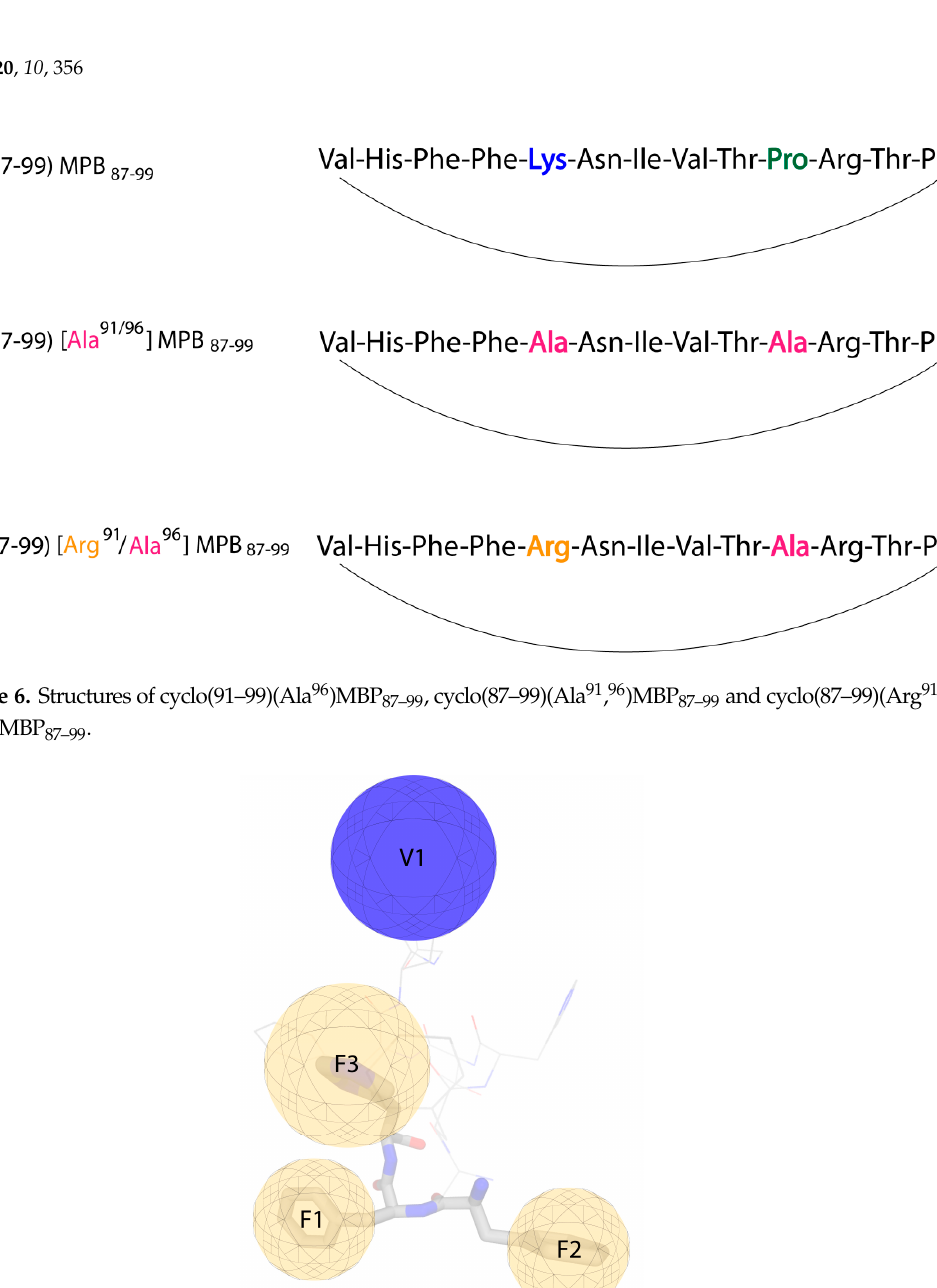
Figure 7. Pharmacophore model depicted using the conformational properties obtained from the conformational analysis for the cyclic altered peptide ligands (APLs). Exclusion volume V1 is presented with a blue sphere, feature F1 (Phe 90 ), F2 (Phe 89 ), F3 (Phe 88 ) with a yellow sphere.